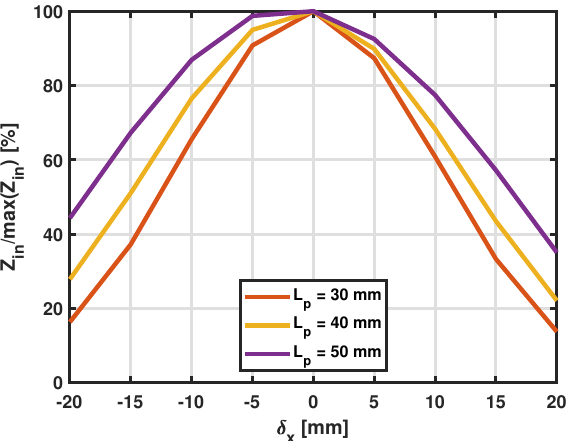
Figure 5. Input impedance variation, expressed as percentage of maximum real input impedance, as the degree of lateral misalignment changes for an SR with L tag = 30 mm interrogated by a probe of varying side